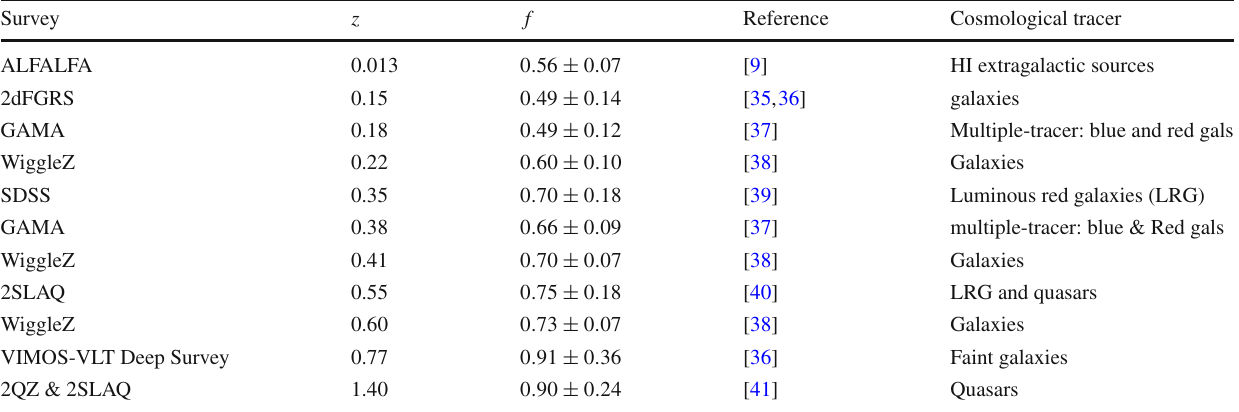
Table 1 Data compilation of 11 f ( z ) measurements; see Sect. 3 for details